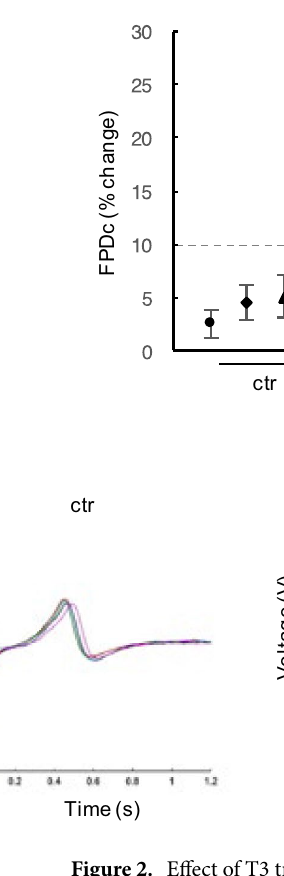
Figure 2. Effect of T3 treatment on FPDc in hiPSC-CMs. Upper panel: analysis of FPDc in hiPSC-CMs treated for 3, 6, 12 and 24 h with 10 nM and 100 nM T3 compared with vehicle treated cells (ctr); data are expressed as the percentage change of FPDc compared to baseline values; lower panel: representative extracted FPD waveforms of hiPSC-CMs treated with T3 at the indicated doses. *p < 0.05 and **p <